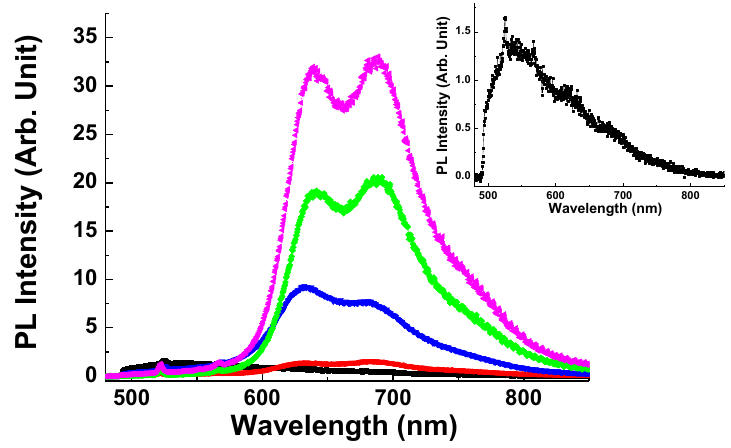
Figure 6. LCM PL spectra of doped P3MT (black line), P3MT/pDNA (red line), P3MT/pDNA-tDNA (10 – 10 pairs) (blue line), P3MT/pDNA-tDNA (20 – 20 pairs) (green line) and P3MT/pDNA-tDNA (30 – 30 pairs) (pink line) NWs. Inset: Magnified LCM PL spectra of doped P3MT NWs.